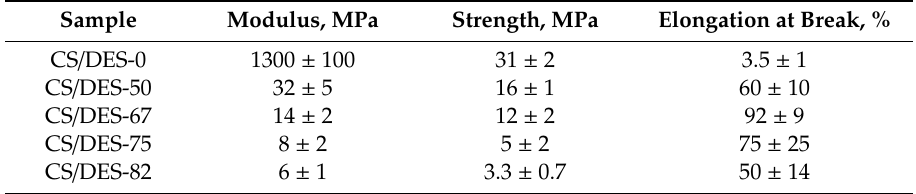
Table 5. The values of room temperature ionic conductivity ( σ ), diffusion coefficient of ions ( D ), mobility ( μ ) and number density of charge carriers ( n ) and activation energy of ionic conductivity ( E a ) for CS film with LA and films with different NADES content.